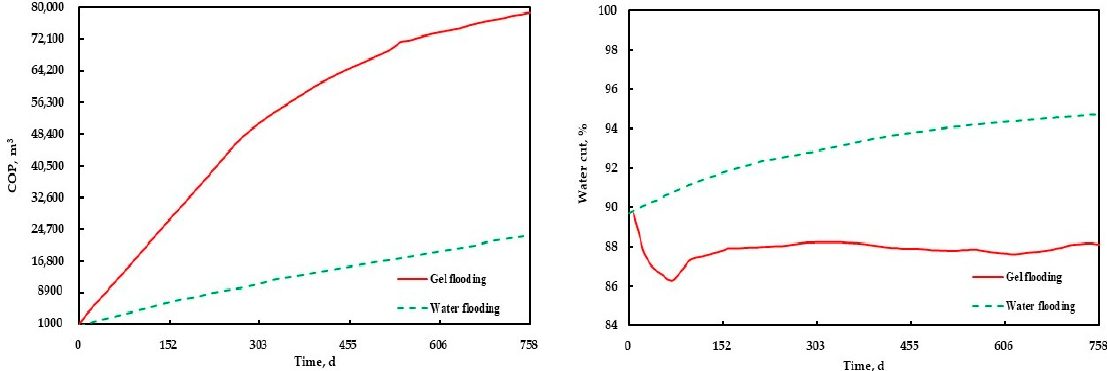
Figure 17. The COP and water cut prediction comparison between the optimal gel flooding scheme and water flooding.